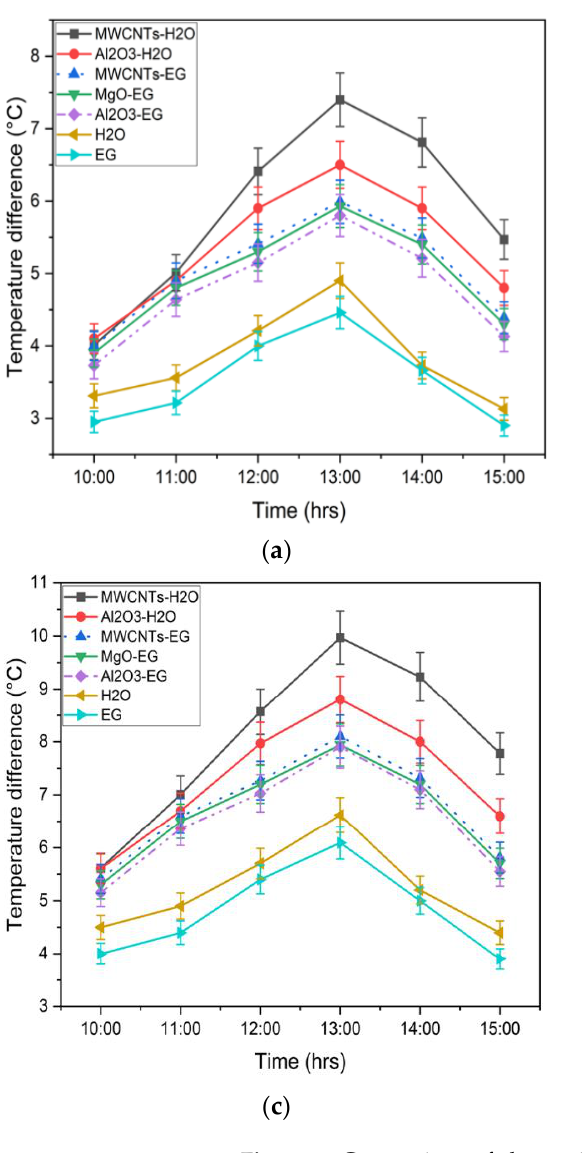
Figure 9. Comparison of change in temperature with regard to time: ( a ) 0.025 vol% at 0.02 kg/s, ( b ) 0.075 vol% at 0.02 kg/s, ( c ) 0.025 vol% at 0.015 kg/s, ( d ) 0.075 vol% at 0.015 kg/s.